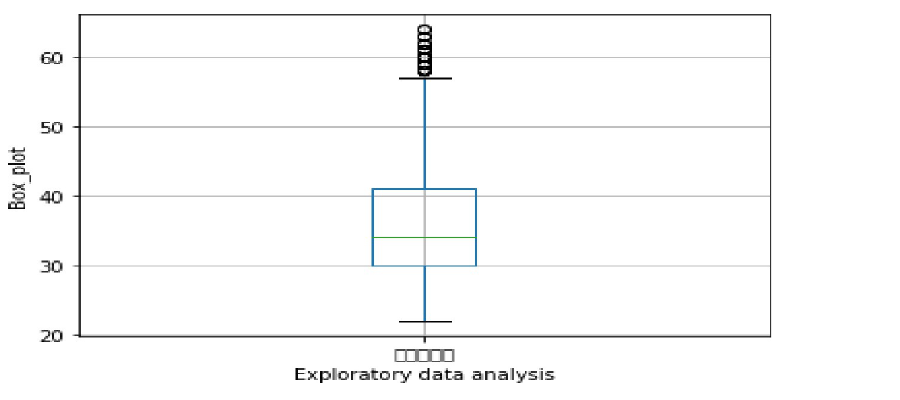
Fig 13. Exploratory data analysis for age